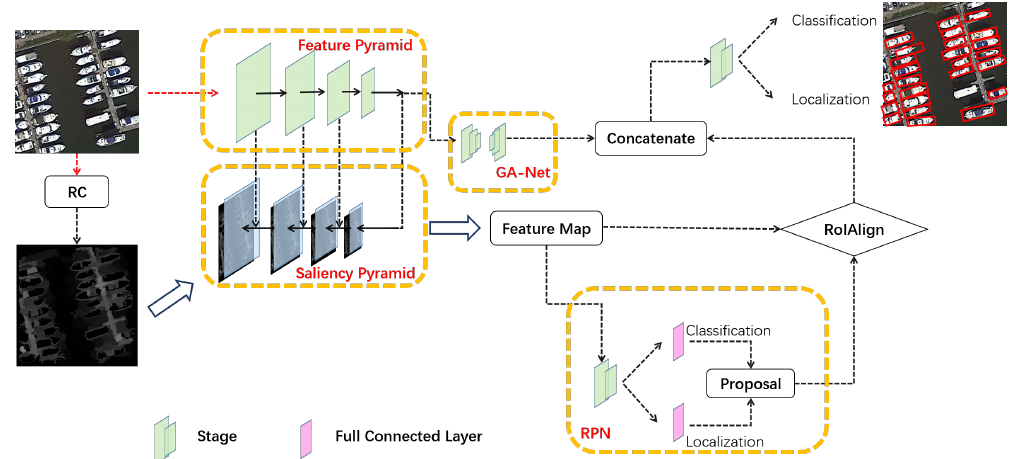
Figure 4. The proposed framework, namely, the global-local saliency constraint network (GLS-Net), is made up of four parts: the baseline network, which is made up of the towards real-time object detection with region proposal networks (Faster R-CNN) [36] and the feature pyramid network (FPN) [37]; the saliency pyramid, which makes the objects more prominent in the region proposals; the global context network with a channel attention mechanism and a lightweight feature fusion structure; and the angle-sensitive non-maximum suppression in R-CNN.